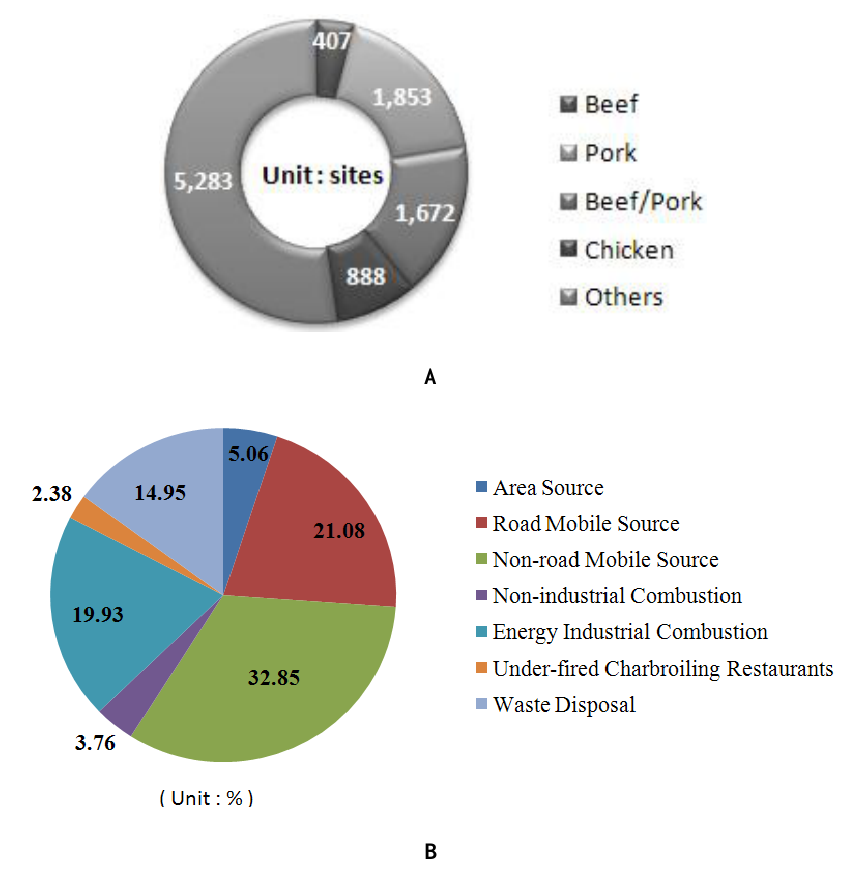
FIGURE 1. Classification of food types for the UFC restaurants and their relative contribution in PM source apportionment. (A) Classification of UFC 10 restaurants on the basis of the main meat types cooked in Seoul (our initial survey, 2008); (B) relative contribution of UFC restaurants in the total source apportionment of PM in Seoul 10